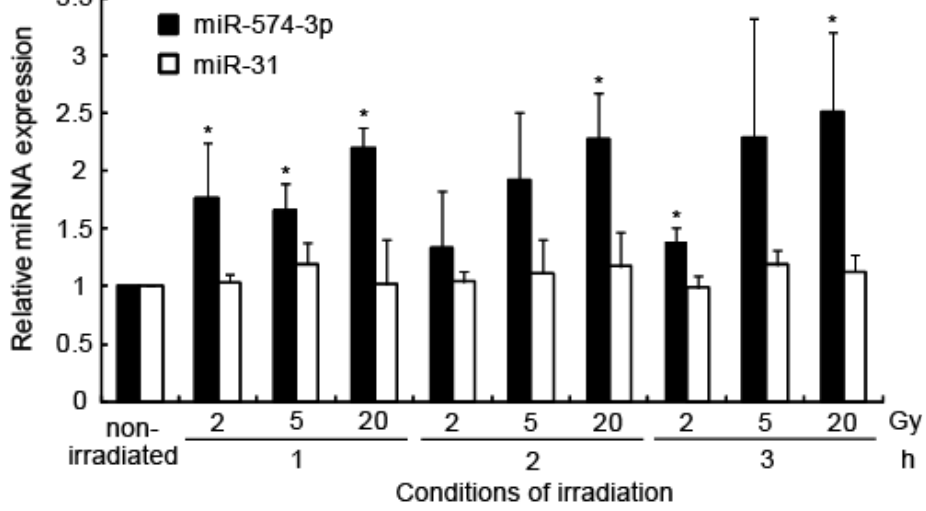
Figure 2. Induction of miR-574-3p after X-ray irradiation. Induction of miR-574-3p in A549 cells 1, 2, and 3 h after irradiation with 2, 5, and 20 Gy X-ray was determined by qRT-PCR, using the delta Ct method. miR-31 was used as a negative control. Error bars represent the standard deviation. Each experiment was conducted three times. * p < 0.05 vs. the non-irradiated